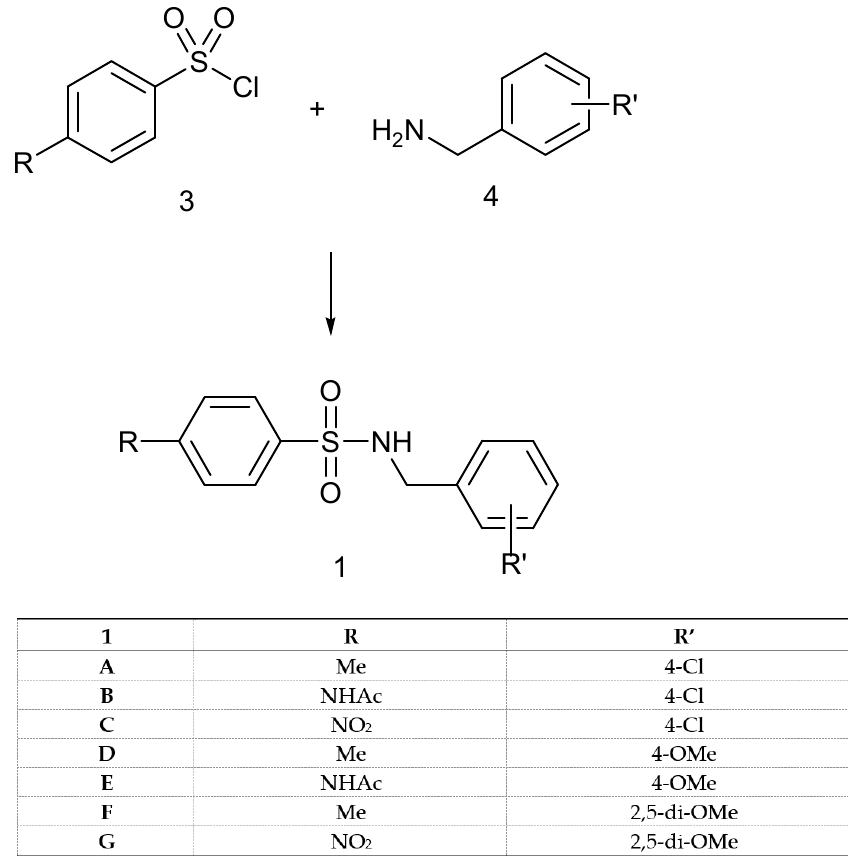
Scheme 1. The general method for the synthesis of benzyl-sulfonamides of type 1.